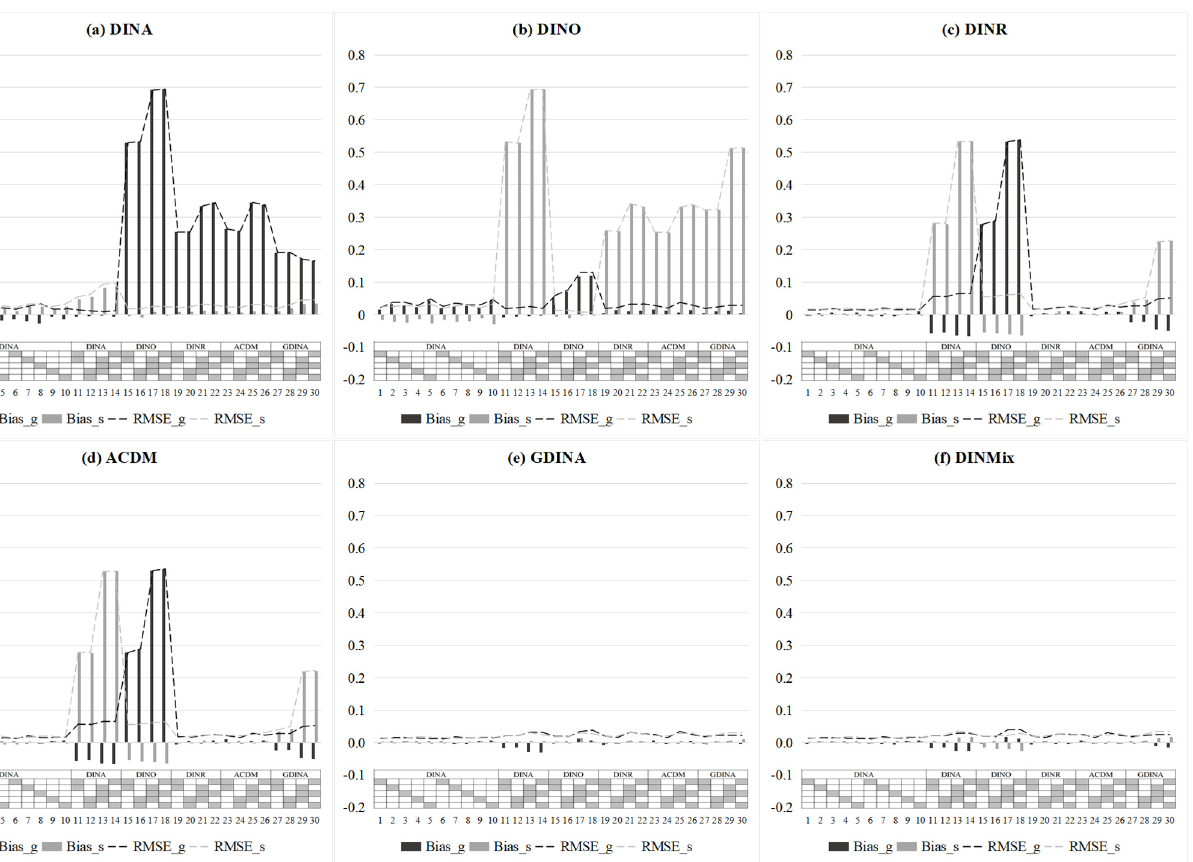
Figure 7. Item-level –2LCPO of six models in simulation Study 2. Note: The value is the mean value of 30 replications; –2LCPO = –2 log conditional predictive ordinate; DINA = deterministic input, noisy ‘and’ gate model; DINO = deterministic input, noisy ‘or’ gate model; DINR = deterministic input, noisy ratio model; ACDM = additive cognitive diagnosis model; GDINA = generalized DINA model; DINMix = deterministic input, noisy mixed model.